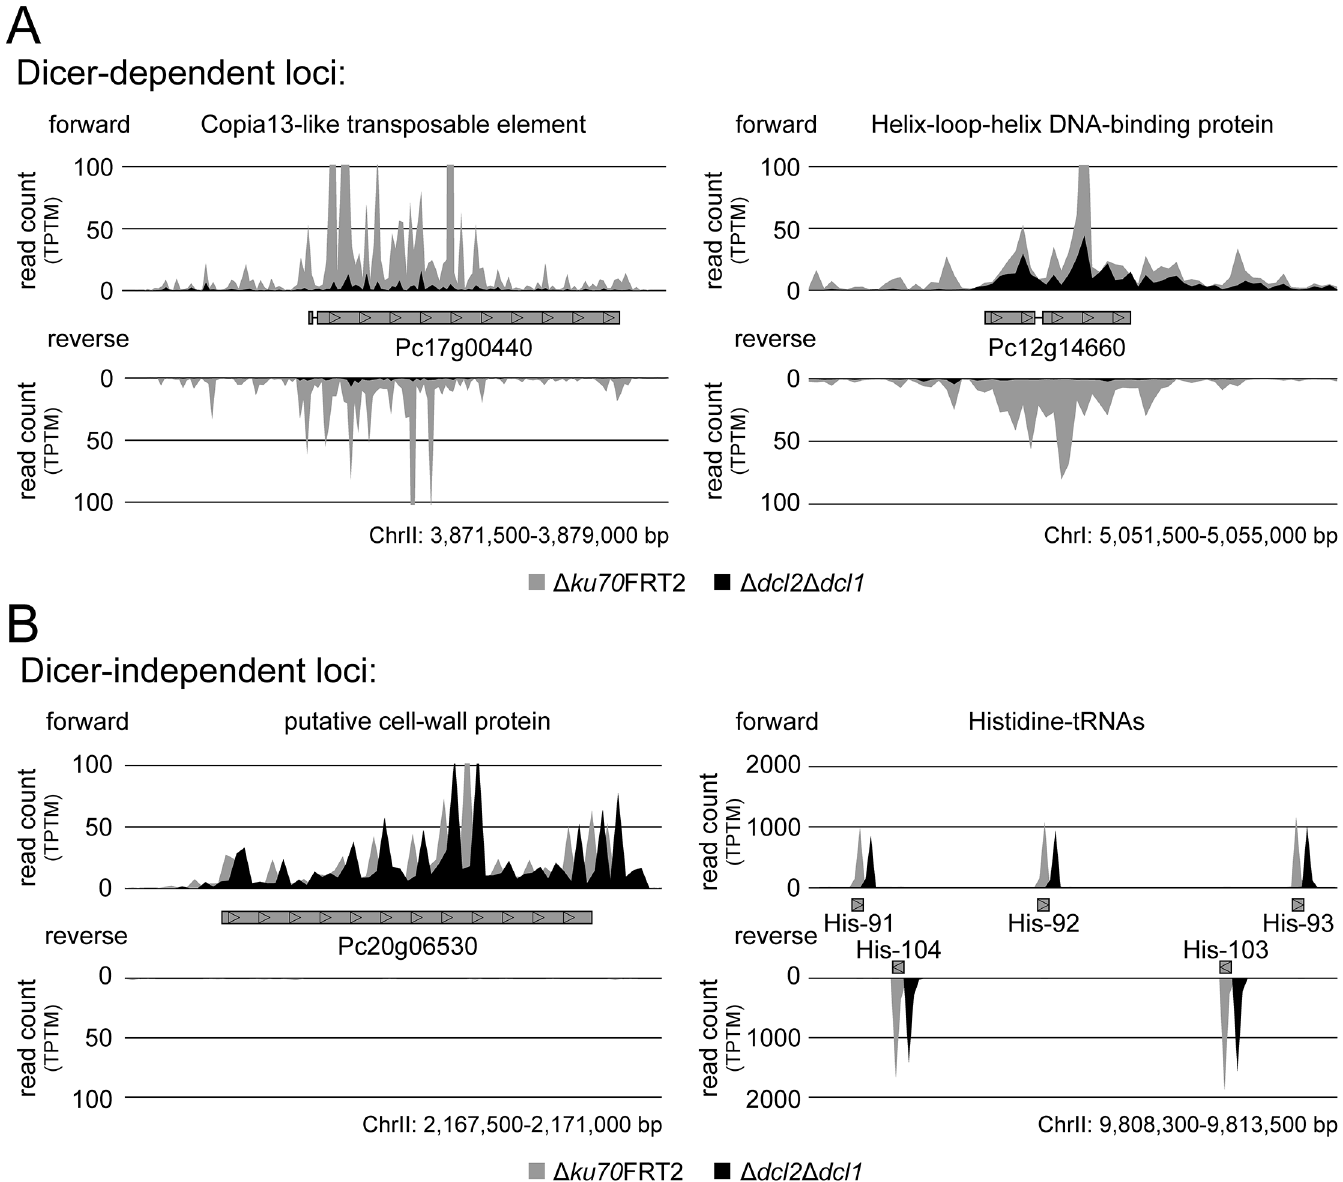
Fig 4. Accumulation of sRNAs along representative coding-sequences. (A) Normalized read count (TPTM: transcripts per ten million) of Δ ku70 FRT2 (grey graph) and Δ dcl2 Δ dcl1 (black graph) of two representative Dicer-dependent coding regions, the Copia13-like transposable element Pc17g00440 and the putative DNA-binding protein Pc12g14660. (B) Dicer-independent sRNA accumulation for the coding region of the putative cell-wall protein Pc20g06530 and for a histidine tRNA-gene cluster. To ensure a faultless representation of Dicer-independent reads the graphs for Δ dcl2 Δ dcl1 were slightly moved to the